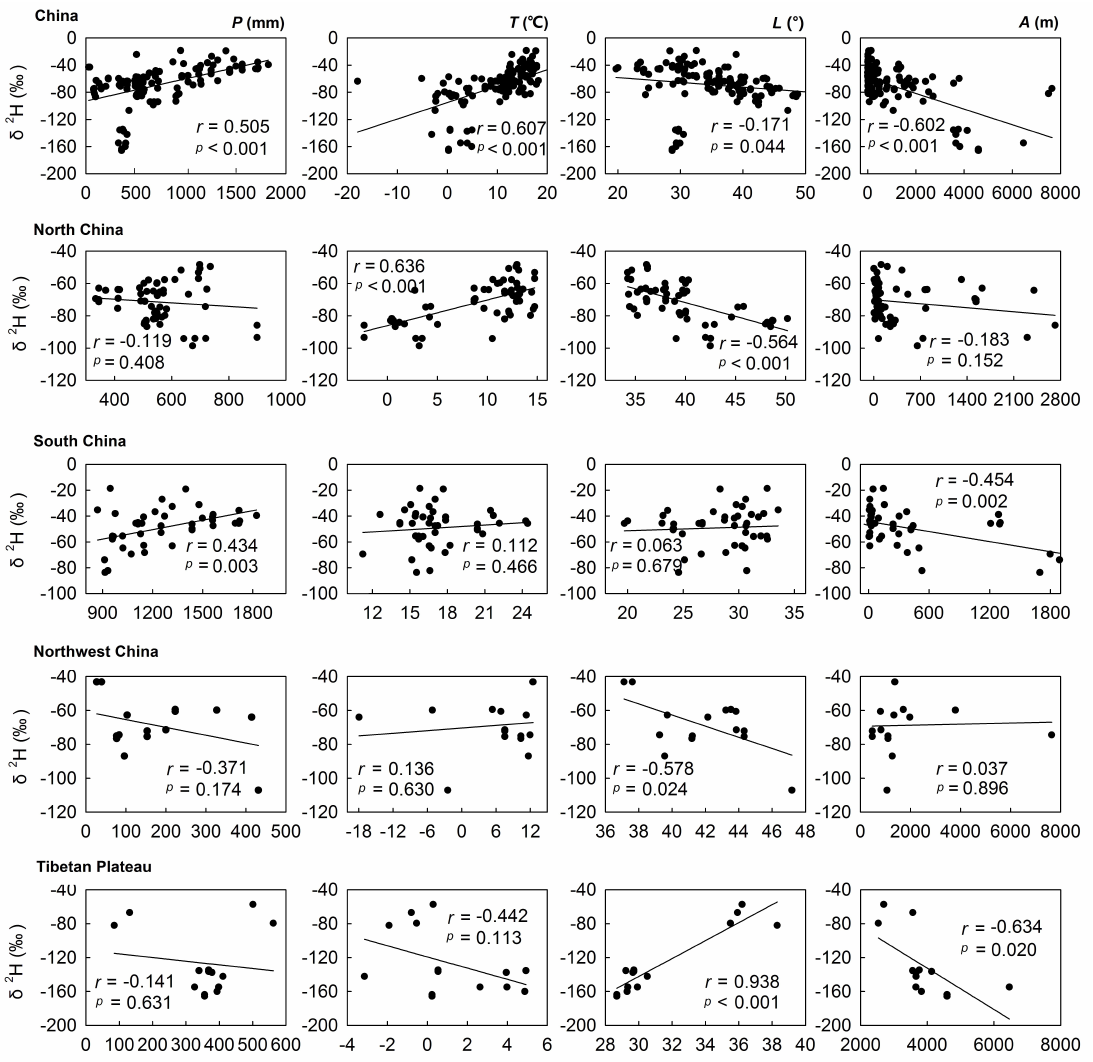
Figure 4. Correlations between measured δ 2 H values of bottled water and four environmental parameters (annual mean precipitation P (mm), annual mean temperature T (°C), latitude L (°) and altitude A (m)) for the period 1970–2000. The top row shows all data for the whole of China, and below are the four natural regions.